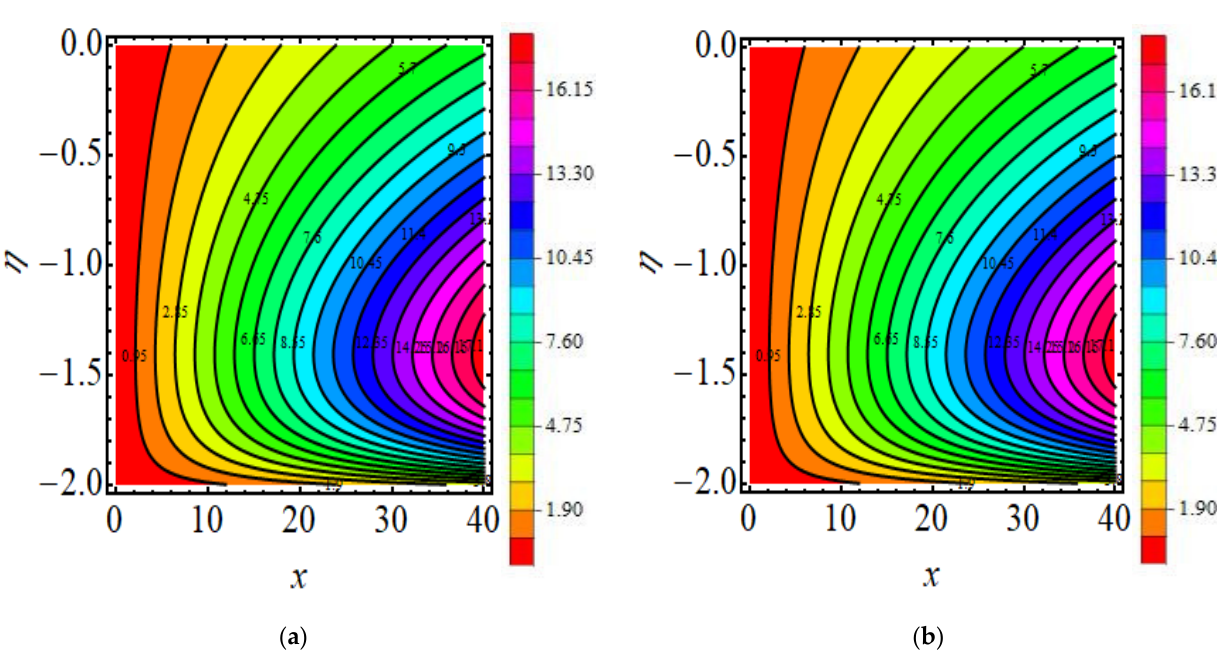
β= − β= − β= − 2.5 β= − ( b ) 2.5 .18. Major Outcomes .18. Major Outcomes Figure 12. ( a , b ) Isotherms lines ( a ) β = − 2.5 ( b ) β = − 2.5.18. Major